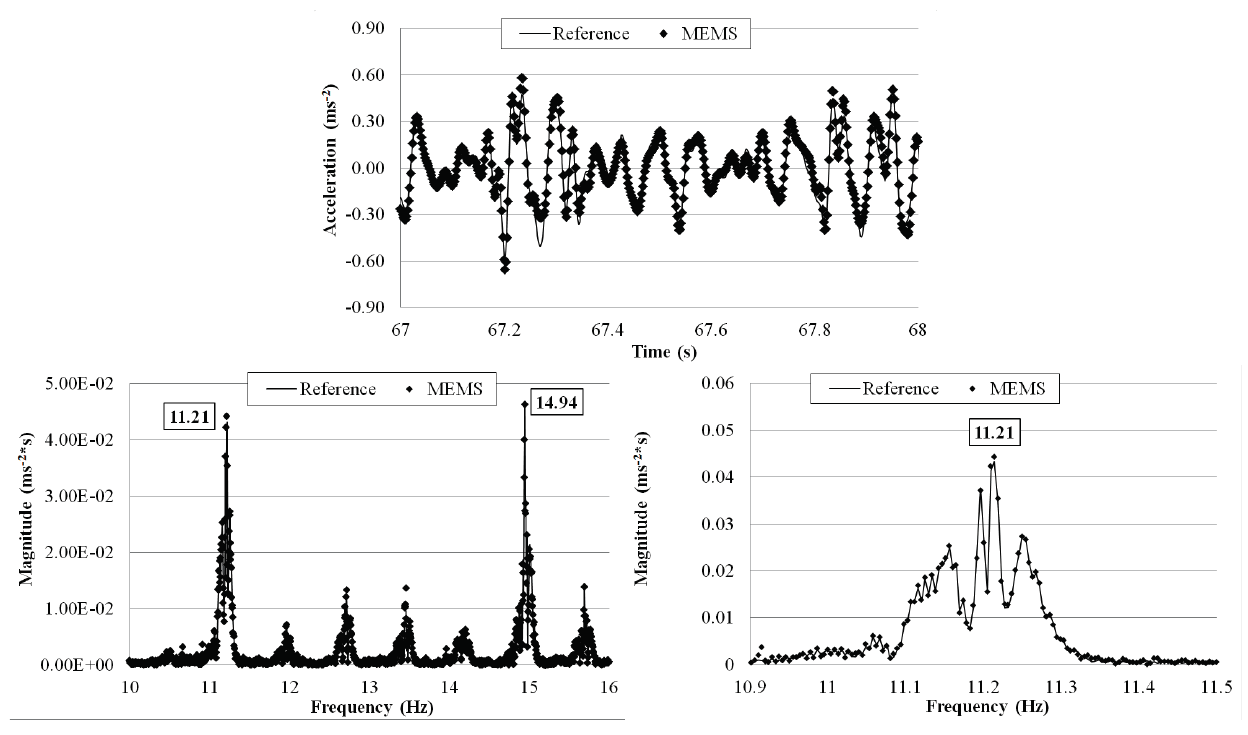
Figure 26. Comparison of measurements by the two sensors in time and frequency domains (8.00 × 10 − 4 m 3 ·s − 1 flow